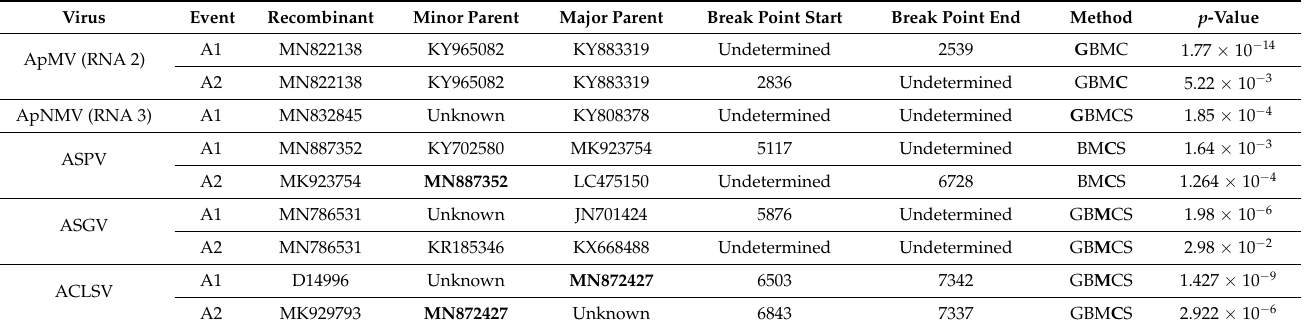
Table 4. The recombination events detected along with major and minor parents and p -value of viruses detected in apple trees using next-generation